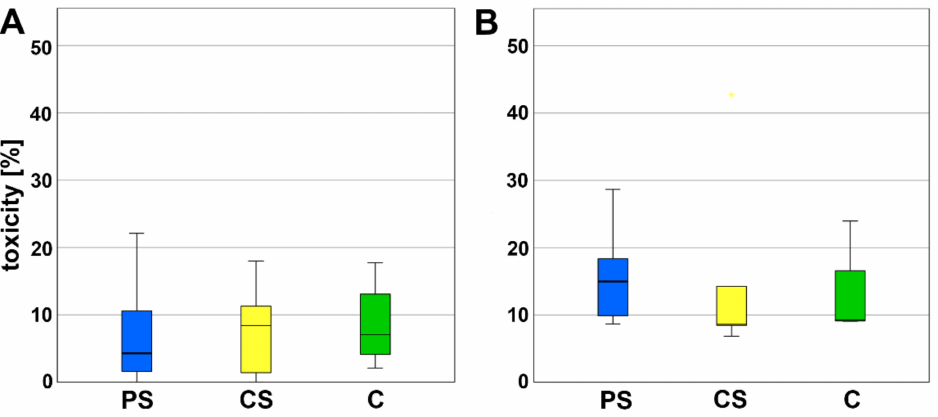
Figure 2. LDH assay ( A ) after 3 (d) and ( B ) 6 days of incubation. PS—porous scaffolds, CS—compact scaffolds, C—control on cell culture